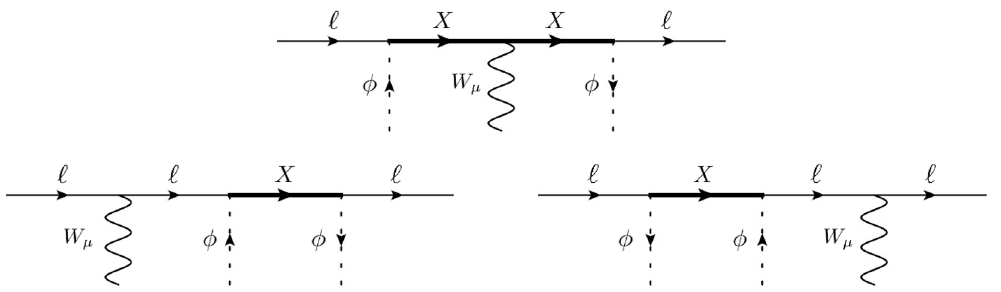
, Q (3) ij and Q ij where X denotes φ‘ φ‘ φe